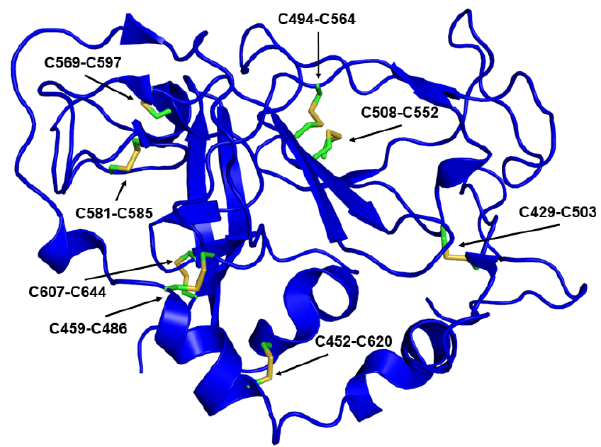
Figure 8. Disulfide bond configuration observed in the E2 ectodomain structure (RCSB ID 6MEI). The numbering shown corresponds to genotype 1b strain 1b09.